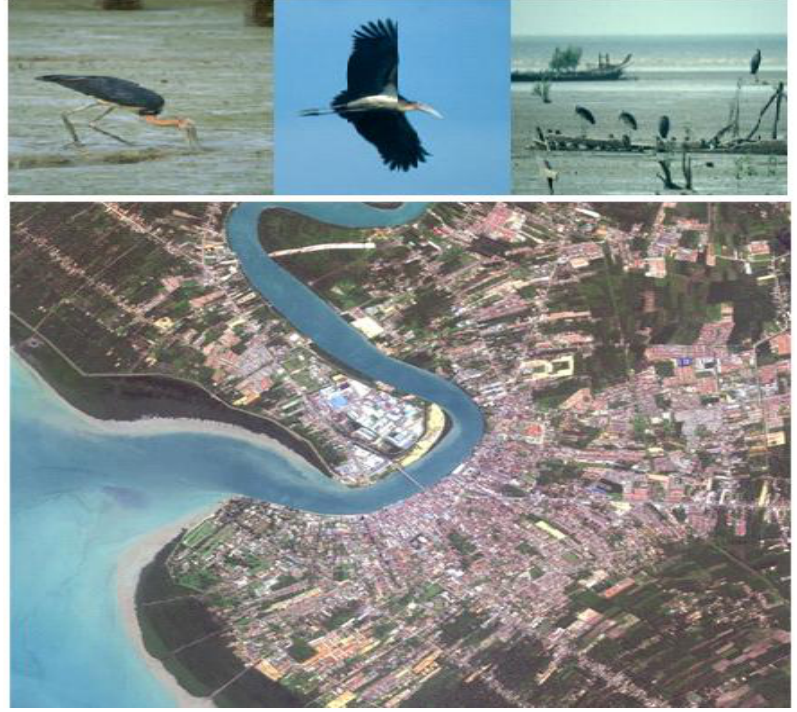
Fig. 2: Birdlife in Muar Town River and the profile of the town of Muar (Bandar